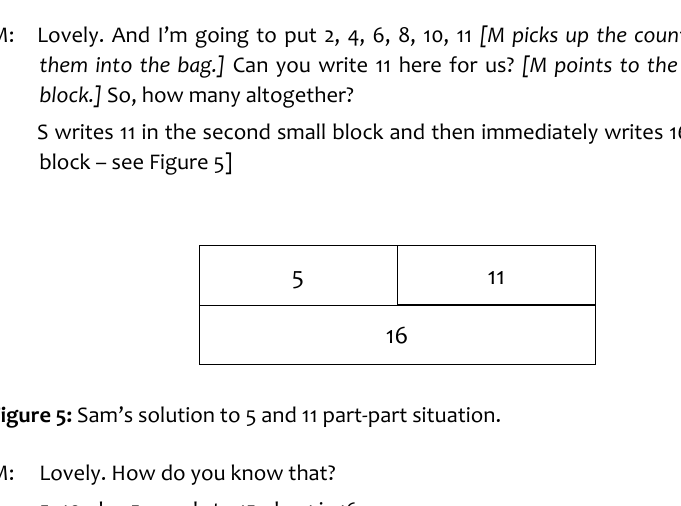
Figure 4: Sam setting up a diagram for 5 counters in the bag.